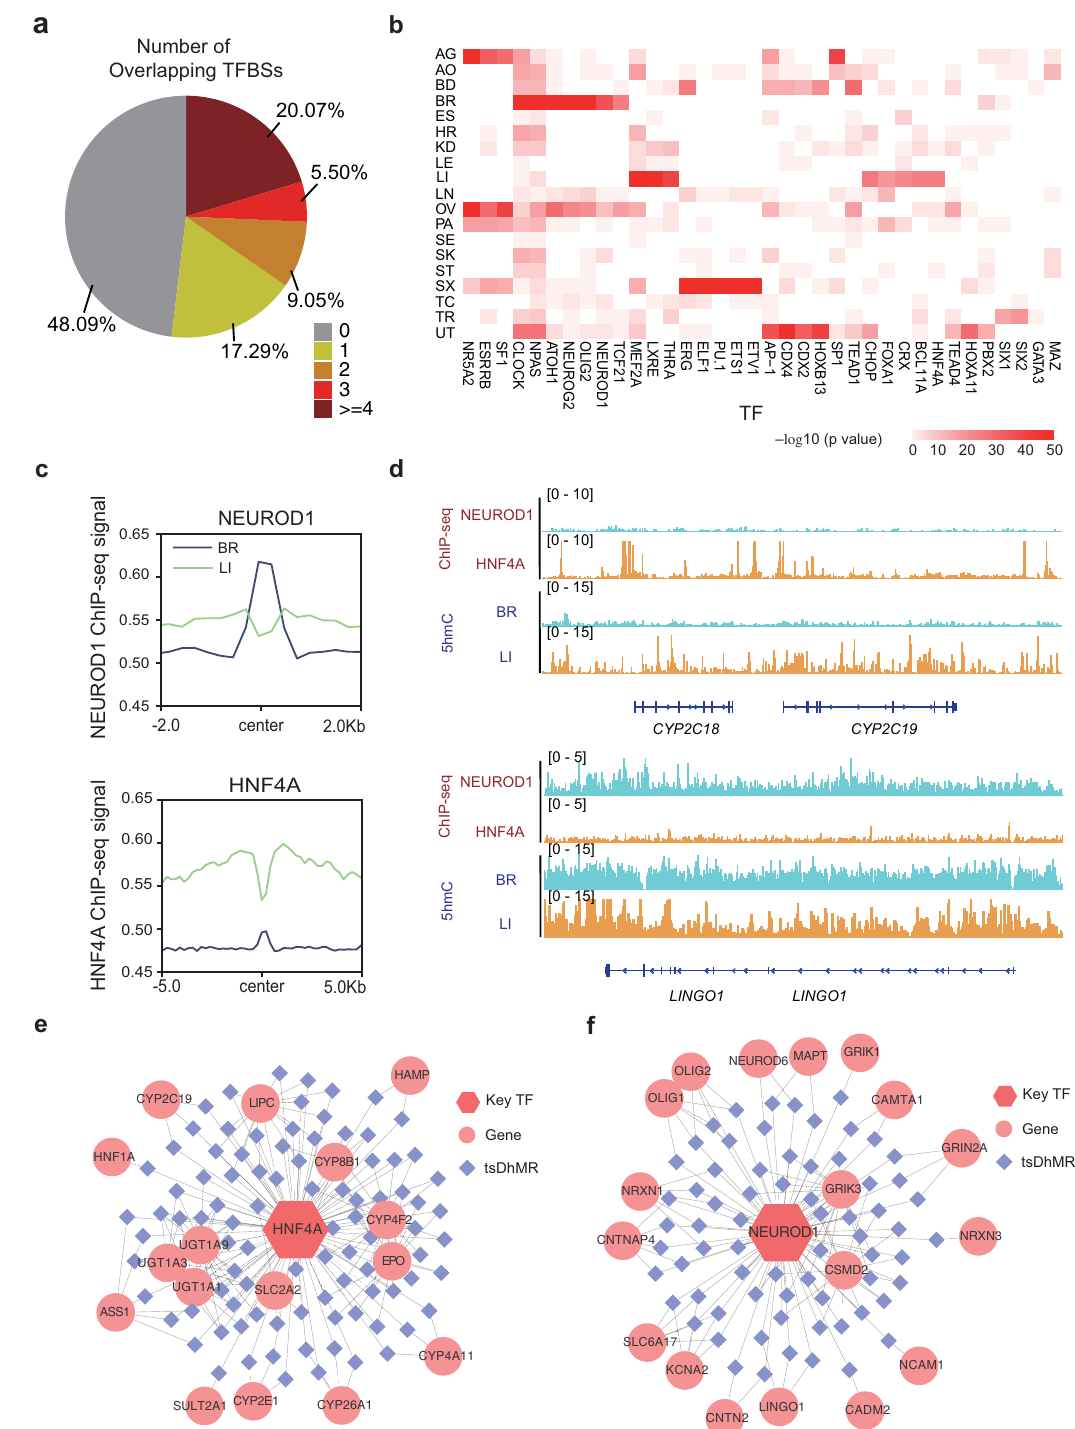
Fig. 5 tsDhMRs are enriched for tissue-speci fi c TFBSs. a Overlap of distal tsDhMRs with ENCODE TFBSs. b The TF motifs enriched in distal tsDhMRs of each tissue. The color scale represents the – log 10 ( P -value). One-side binomial test (default by homer2). c ChIP-seq signals of NEUROD1 and HNF4A around BR-speci fi c DhMRs and LI-speci fi c DhMRs. d IGV visualization of 5hmC signals and ChIP-seq signals of NEUROD1 and HNF4A in the brain and liver. e , f Key TF regulatory networks in the liver ( e ) and brain ( f ). Hexagon represents key TF; rhombi represents tsDhMRs; circles represents regulated genes. Lines linking the hexagon and rhombi indicate that the TF binds to the tsDhMRs, which is supported by TF ChIP-seq